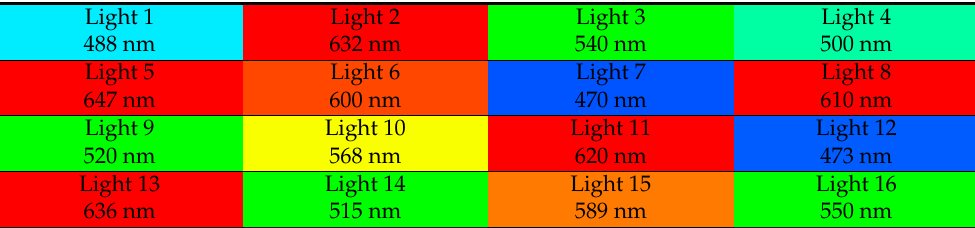
Table 2. Peak wavelength of each light (10 nm